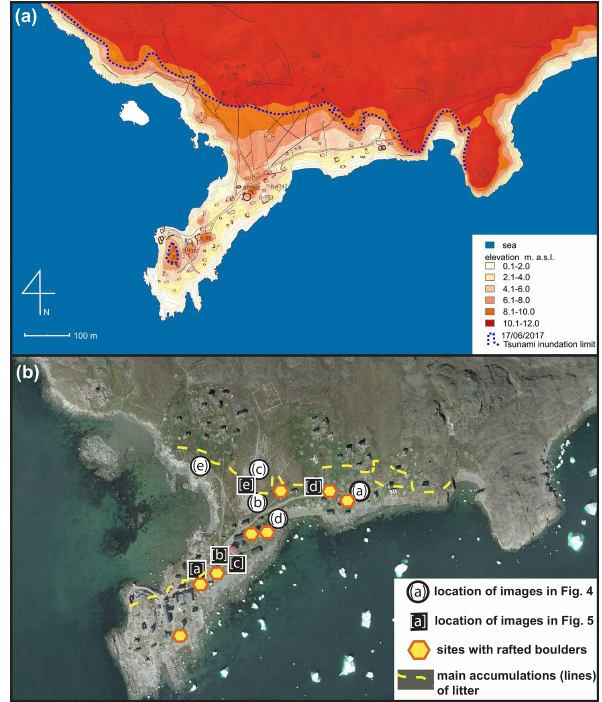
Figure 3. (a) Digital elevation model (2m DEM, https://www.pgc. umn.edu/data/arcticdem/, last access: 21 March 2020) of Nuugaat- siaq with marked tsunami inundation limit (wave flooded the terrain up to 9ma.s.l.). (b) Overview map of the settlement with marked location of images from Figs. 4 and 5. Lines of litter visible in the landscape 2 years after the event and sites where large boulders rafted by tsunami were marked too. Background: technical map of settlement from